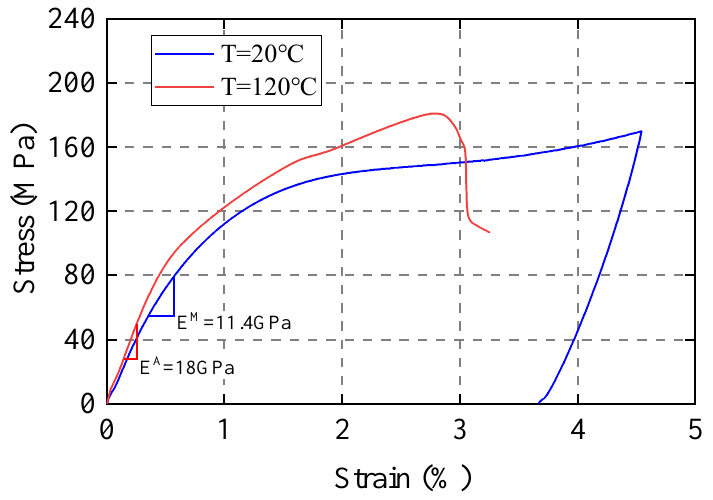
Figure 2. Uniaxial loading results of the SMA strip.